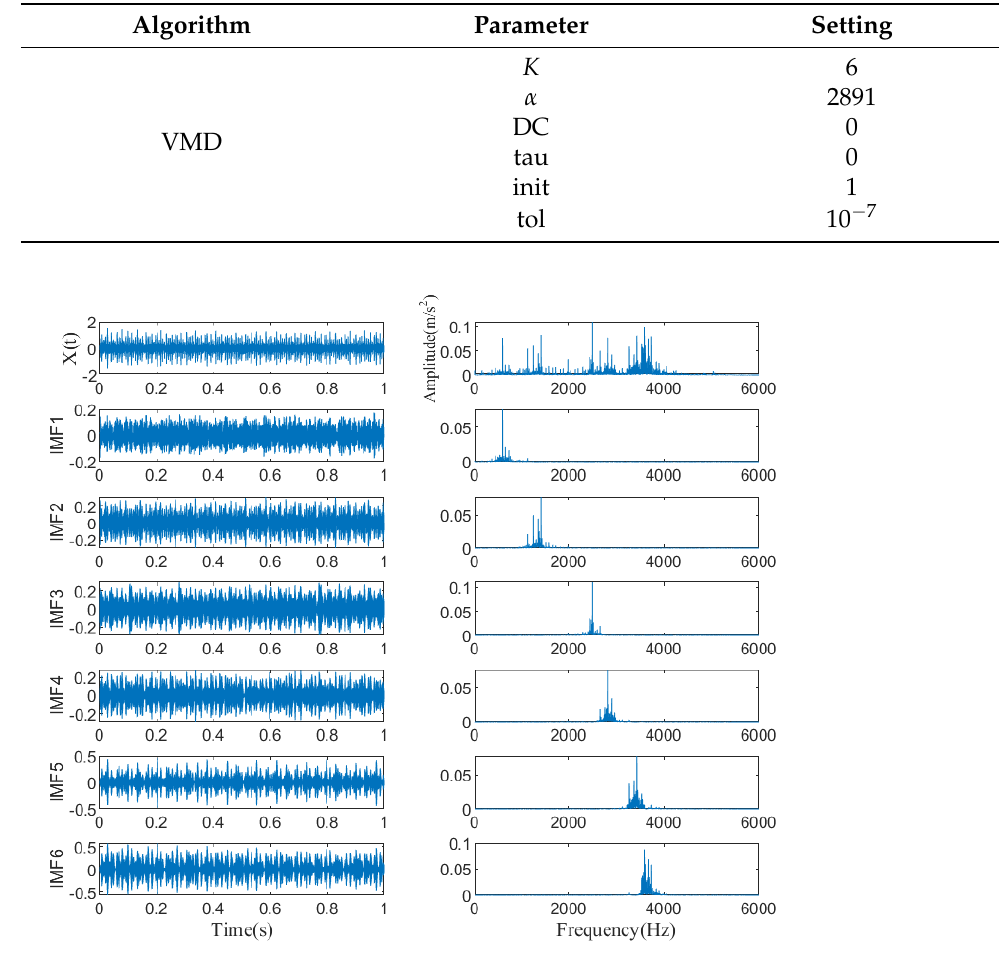
Table 2. Parameter settings for VMD.